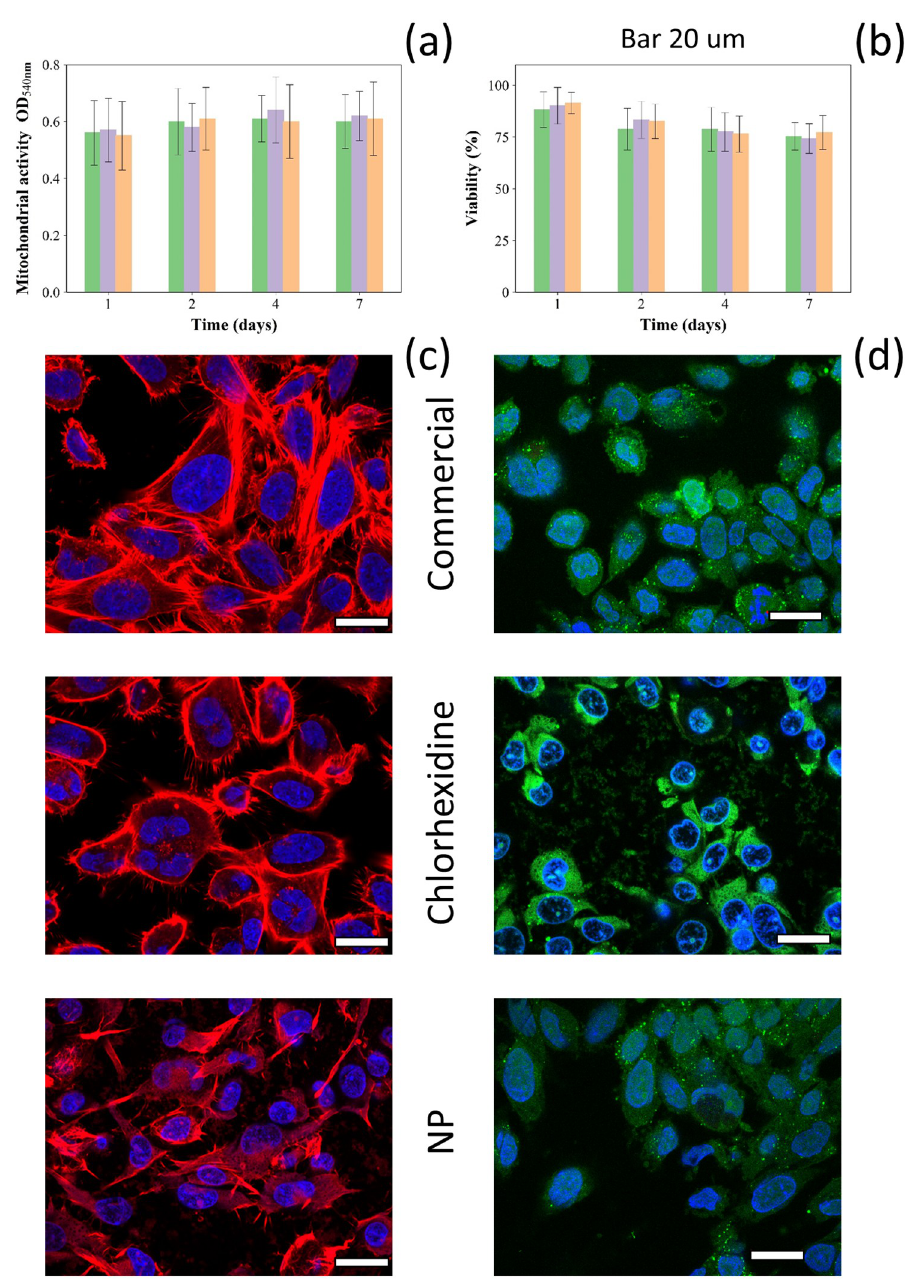
Fig 7. Cytocompatibility of bone cement. (a) Mitochondrial activity (MTT assay) and (b) Viability ratio (composite/ commercial cement) of SaoS-2 cells exposed to Cemex 1 bone cement (green), Cemex 1 containing chlorhexidine powder 3% w/w (violet) and coated silica nanoparticles (orange) for different periods of time (mean ± SD, n = 6). (c) Actin/DAPI and (d) live/dead staining images of SaoS-2 cells exposed to release medium of different bone cement samples. (bar represents 20 μ